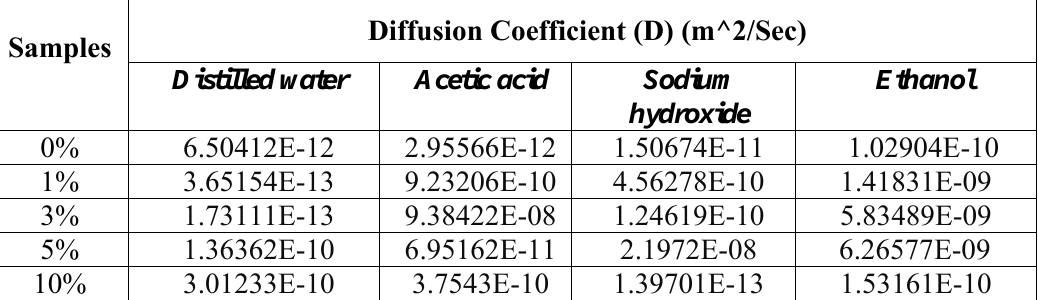
/PVC composites. 2 /PVC composite 2